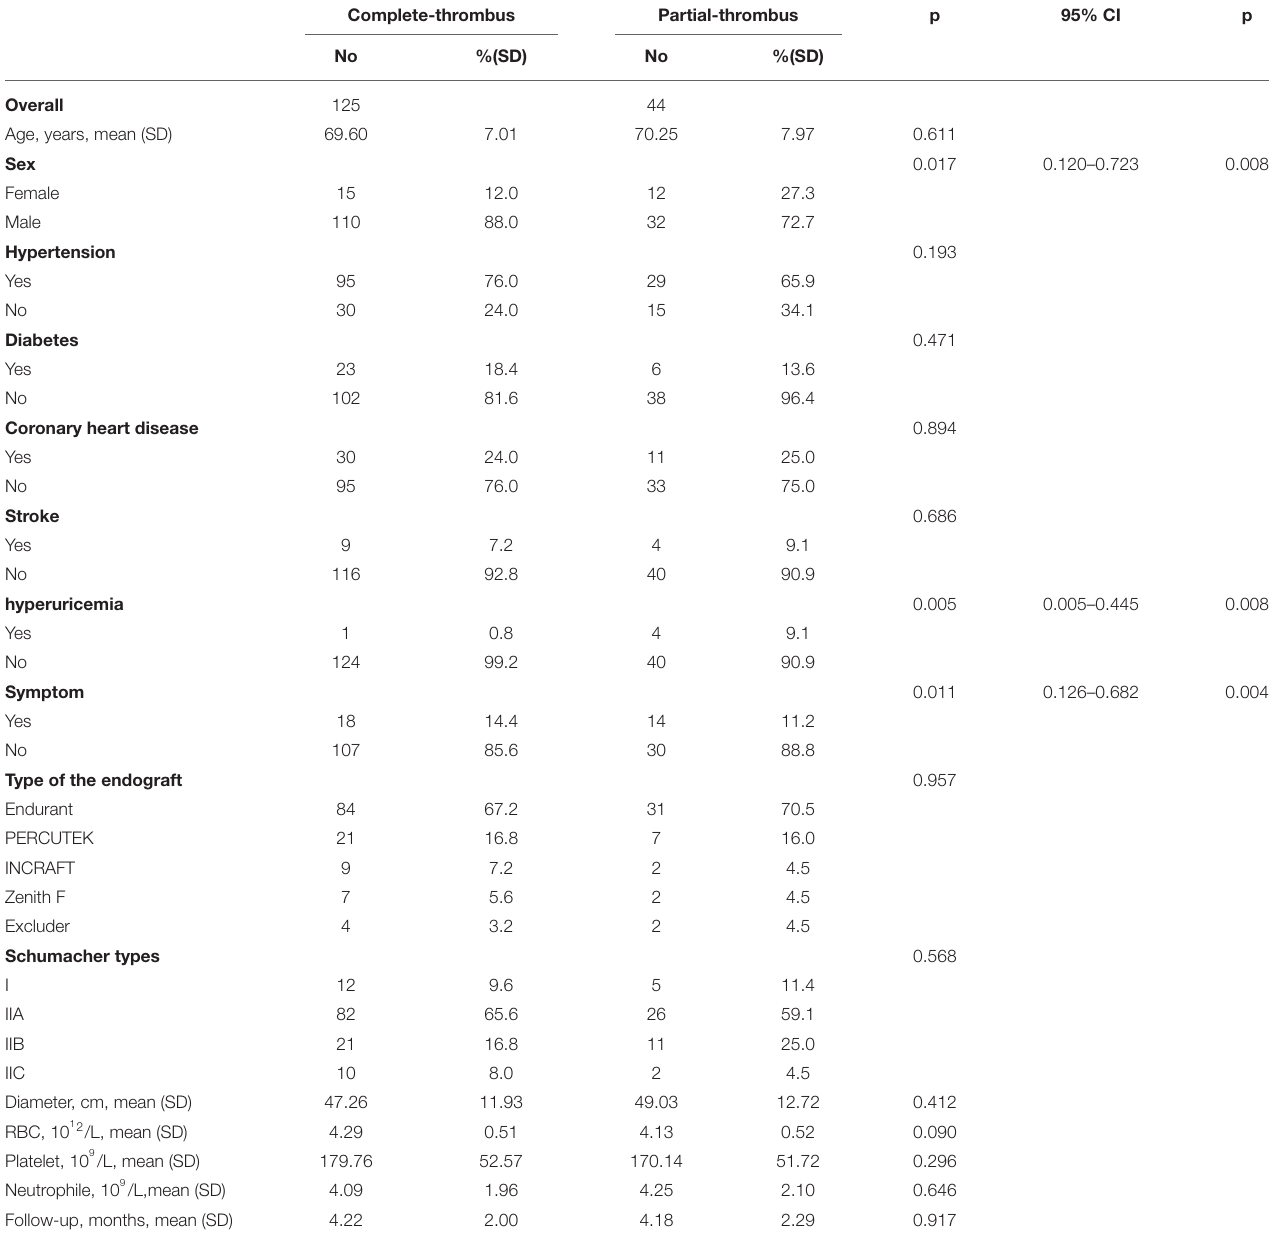
TABLE 2 | Patient characteristics grouped by the thrombus status after EVAR. Complete-thrombus Partial-thrombus